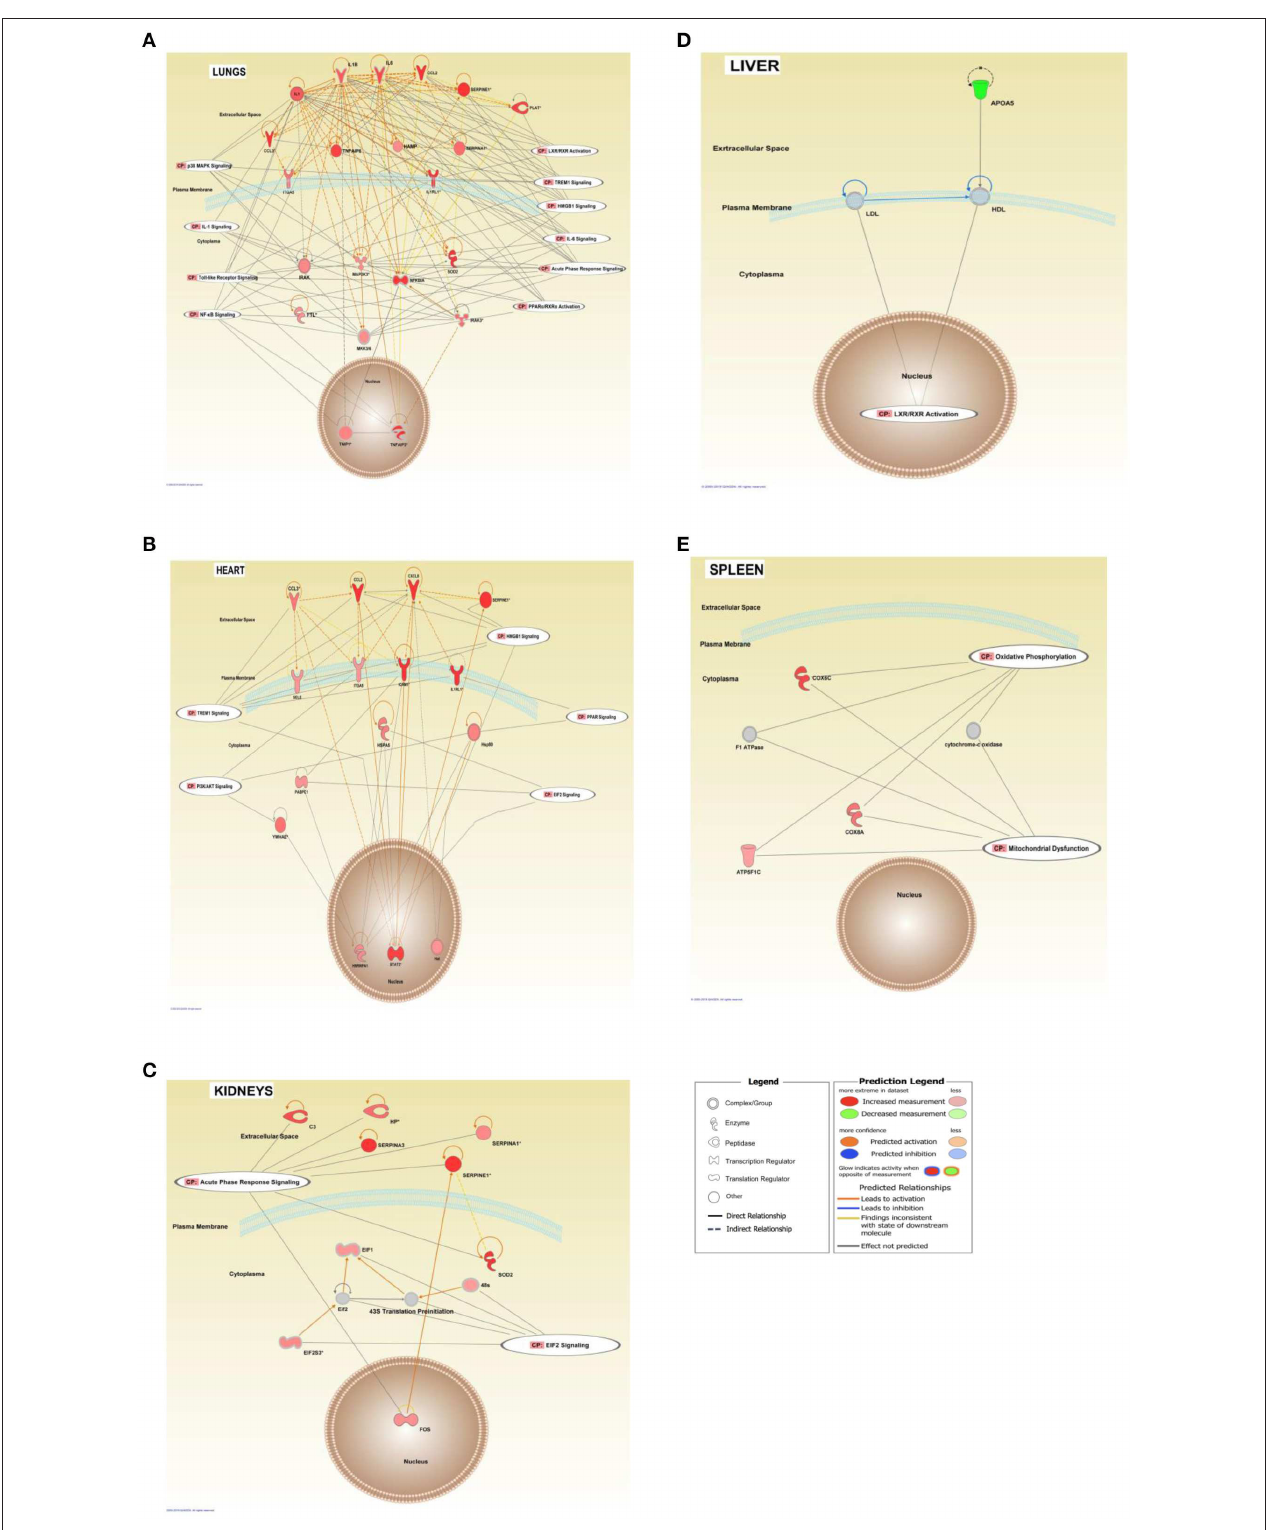
FIGURE 7 | Interaction networks of top score canonical pathways and transcripts affected in FFPE tissue samples from meningococcal septic shock patients. The interaction networks in lungs (A) , heart (B) , kidneys (C) , liver (D) , and spleen (E) are generated through the use of IPA ≪ core analysis ≫ . In addition, ≪ Canonical